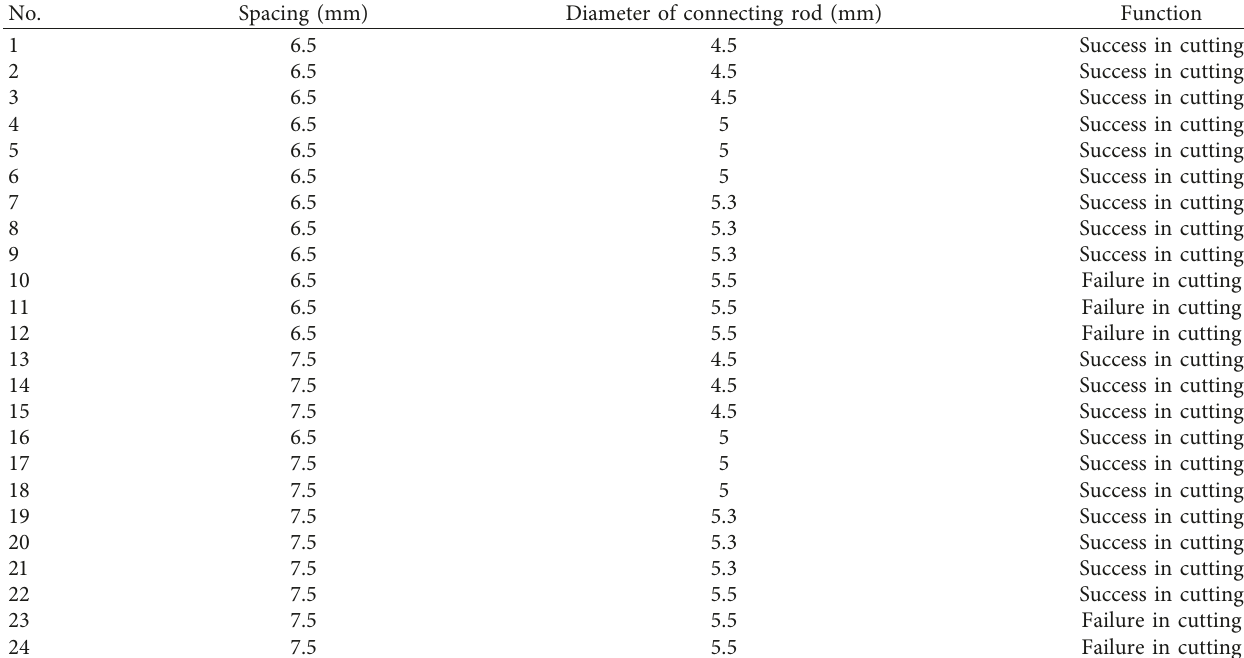
Table 8: Test results for the explosive cutting